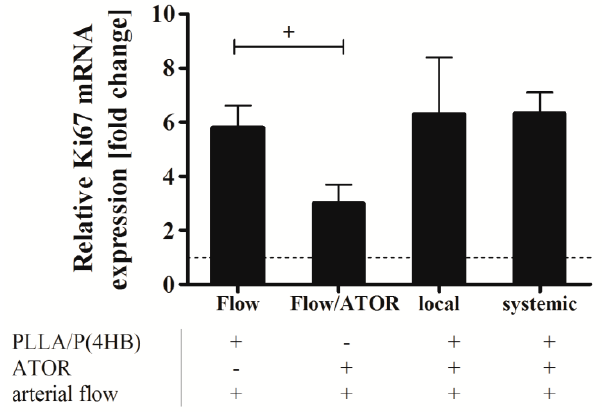
Figure 7. Ki67 expression in human coronary artery smooth muscle cells (HCASMC) after local and systemic atorvastatin (ATOR) administration. HCASMC were cultured on polycarbonate membranes and placed on ATOR-releasing PLLA/P(4HB) surfaces or PLLA/P(4HB) films. Cells were perfused at 20 dyne/cm 2 for 3 h using a parallel plate flow chamber. Perfusion was performed in basal medium supplemented with 2% FBS. Plus (+) and minus ( − ) indicate the presence or absence of a component indicated below the bar chart. After flow exposure, cells were detached and prepared for quantitative RT-PCR. Bars show mean ± SD of at least three separate experiments normalized to HCASMC kept under static conditions in basal medium supplemented with 2% FBS ( + p < 0.05).